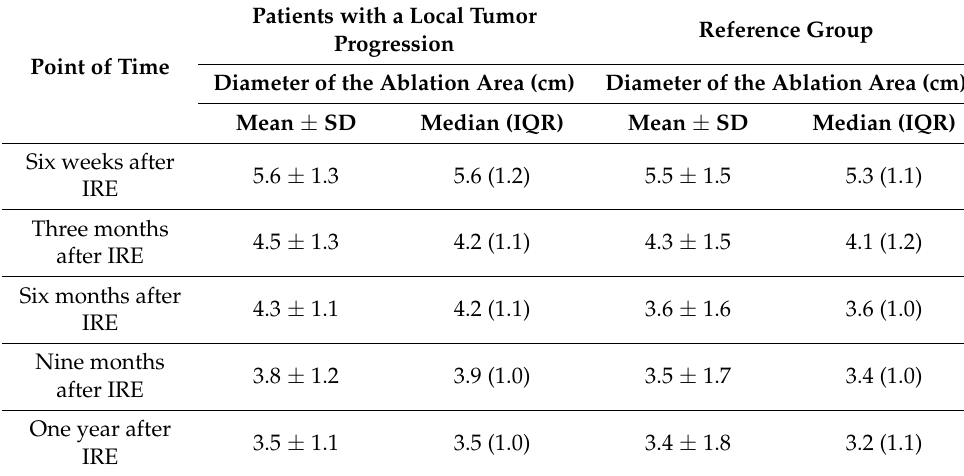
Table 6. Diameter of the ablation area during the